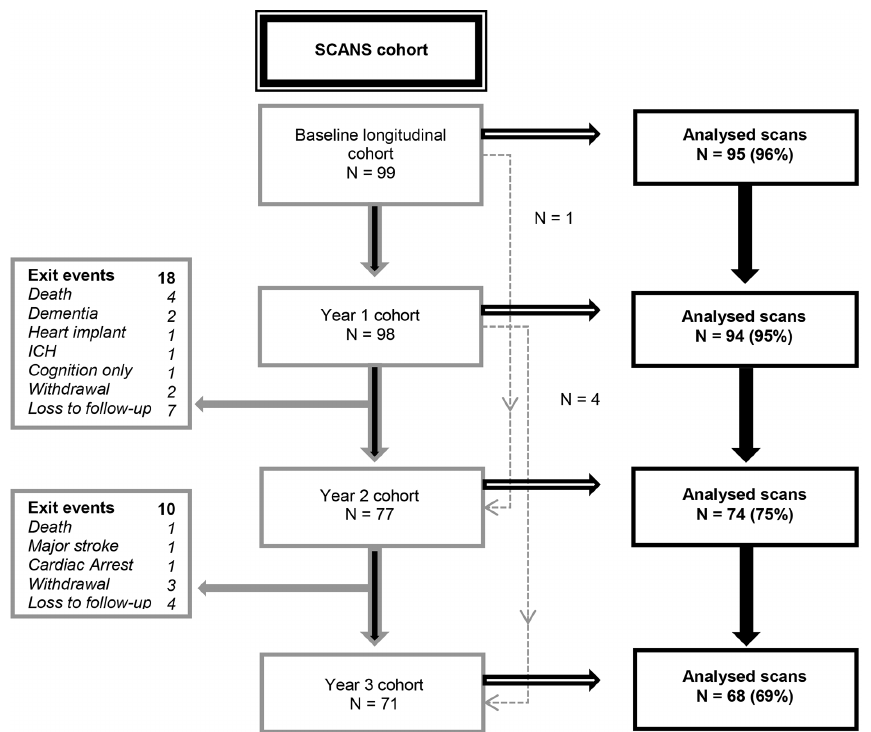
Fig 1. SCANS longitudinal imaging cohort. All available DTI scans without EPI warping were used in our analyses. Exit event coding: Death = patient passed away; Dementia = patient developed a primary dementia syndrome; Heart implant = patient was unable to do further MR sessions due to a heart implant; ICH = subject met exclusion criteria after intracerebral haemorrhage; Cognition only = patient withdrew from MR sessions but remained in study for cognition; Withdrawal = patient formally withdrew from the study; Loss to follow- up = patient was lost to follow-up; Major stroke = patient met exclusion criteria after major ischaemic stroke; Cardiac arrest = major cognitive impairment related to hypoxia was seen in a patient after a cardiac